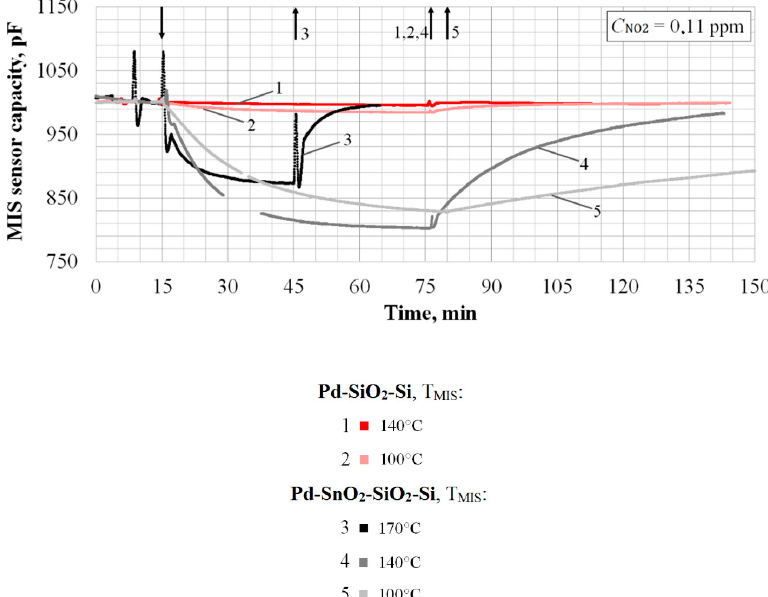
Figure 11. Responses MIS sensors with structures Pd–SiO 2 –Si ( d Pd = 3 mm) and Pd–SnO 2 –SiO 2 –Si ( d Pd = 2 mm) to concentration of NO 2 0.11 ppm at di ff erent sensor temperature T MIS . The moments of the beginning and finishing of the concentration submission are shown by arrows.